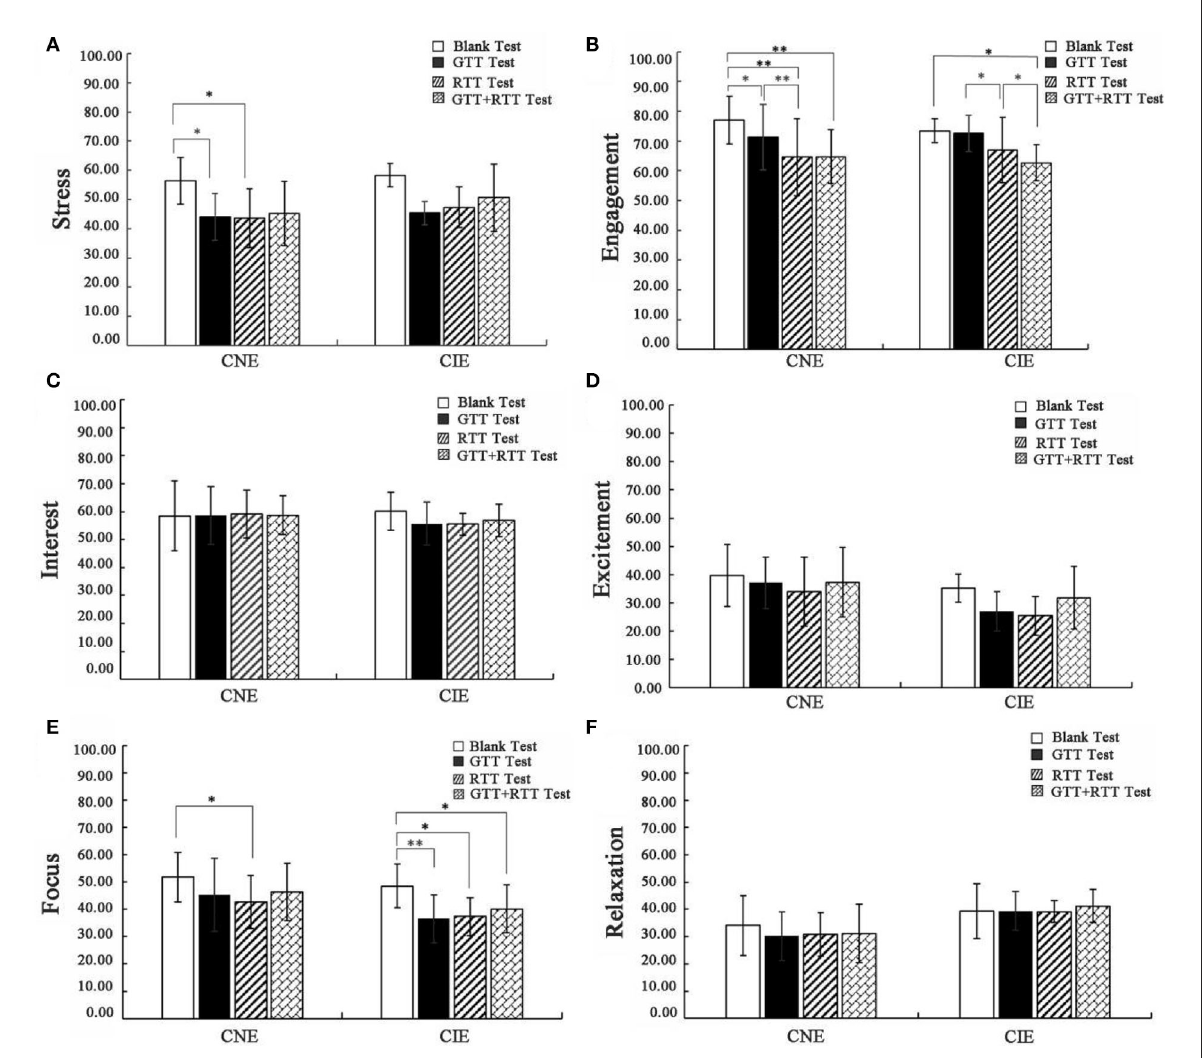
FIGURE4 Significance of difference analysis between tests ( ** sig. < 0.01, * sig, < 0.05). (A) Stress. (B) Engagement. (C) Interest. (D) Excitement. (E) Focus. (F)